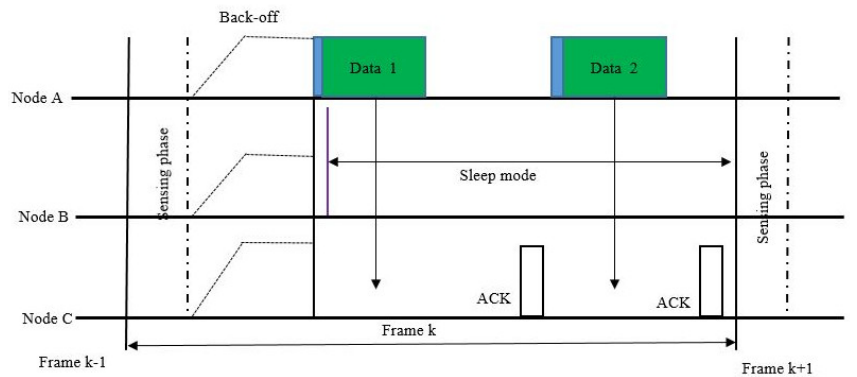
Figure 6 . Example of operation of the energy-efficient MAC Protocol for IEEE 802.11-based cognitive radio networks radio networks (CRNs).